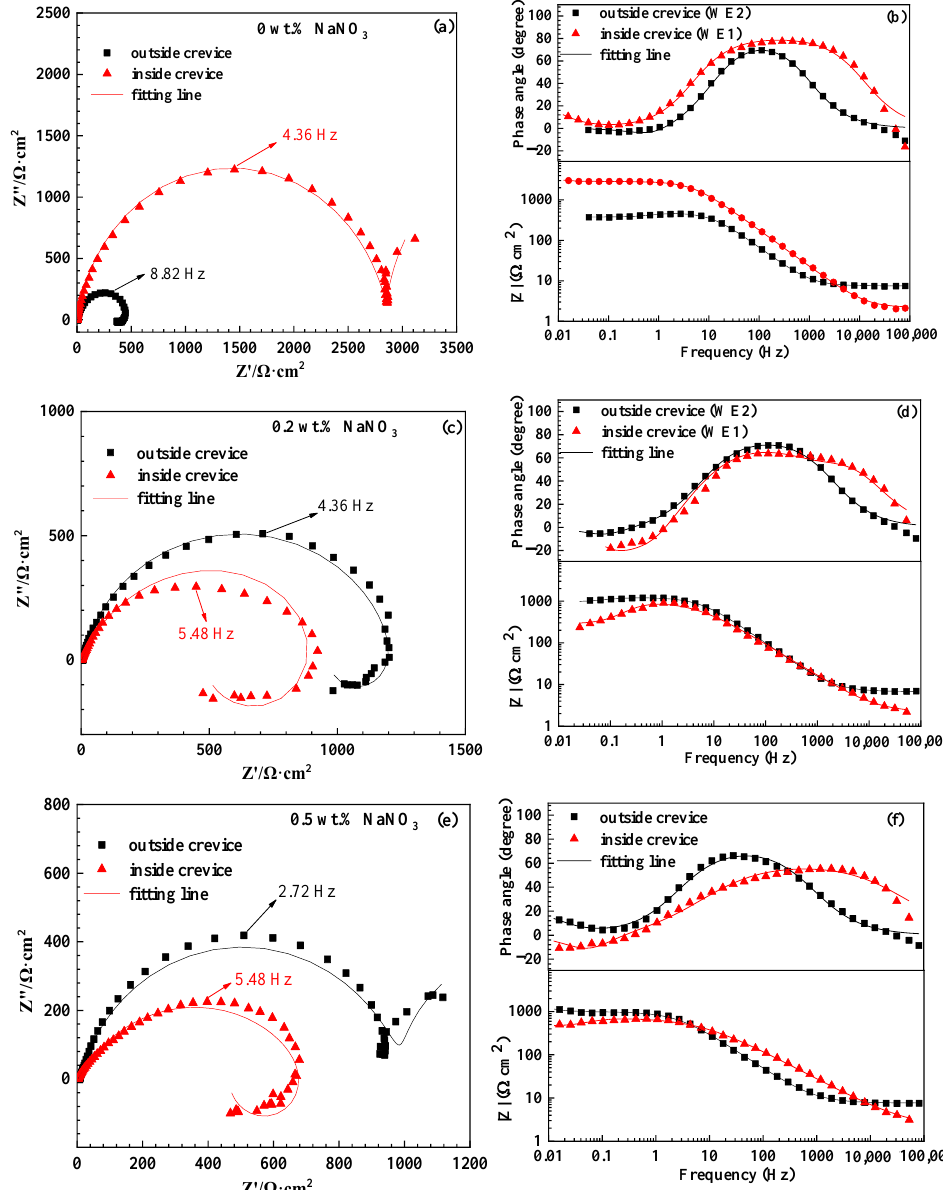
Figure 5. The EIS of specimens inside and outside the crevice in solutions with different concentrations of NaNO 3 after corrosion for 24 h. ( a , b ) 0 wt.% NaNO 3 , ( c , d ) 0.2 wt.% NaNO 3 , ( e , f ) 0.5 wt.% NaNO 3 .